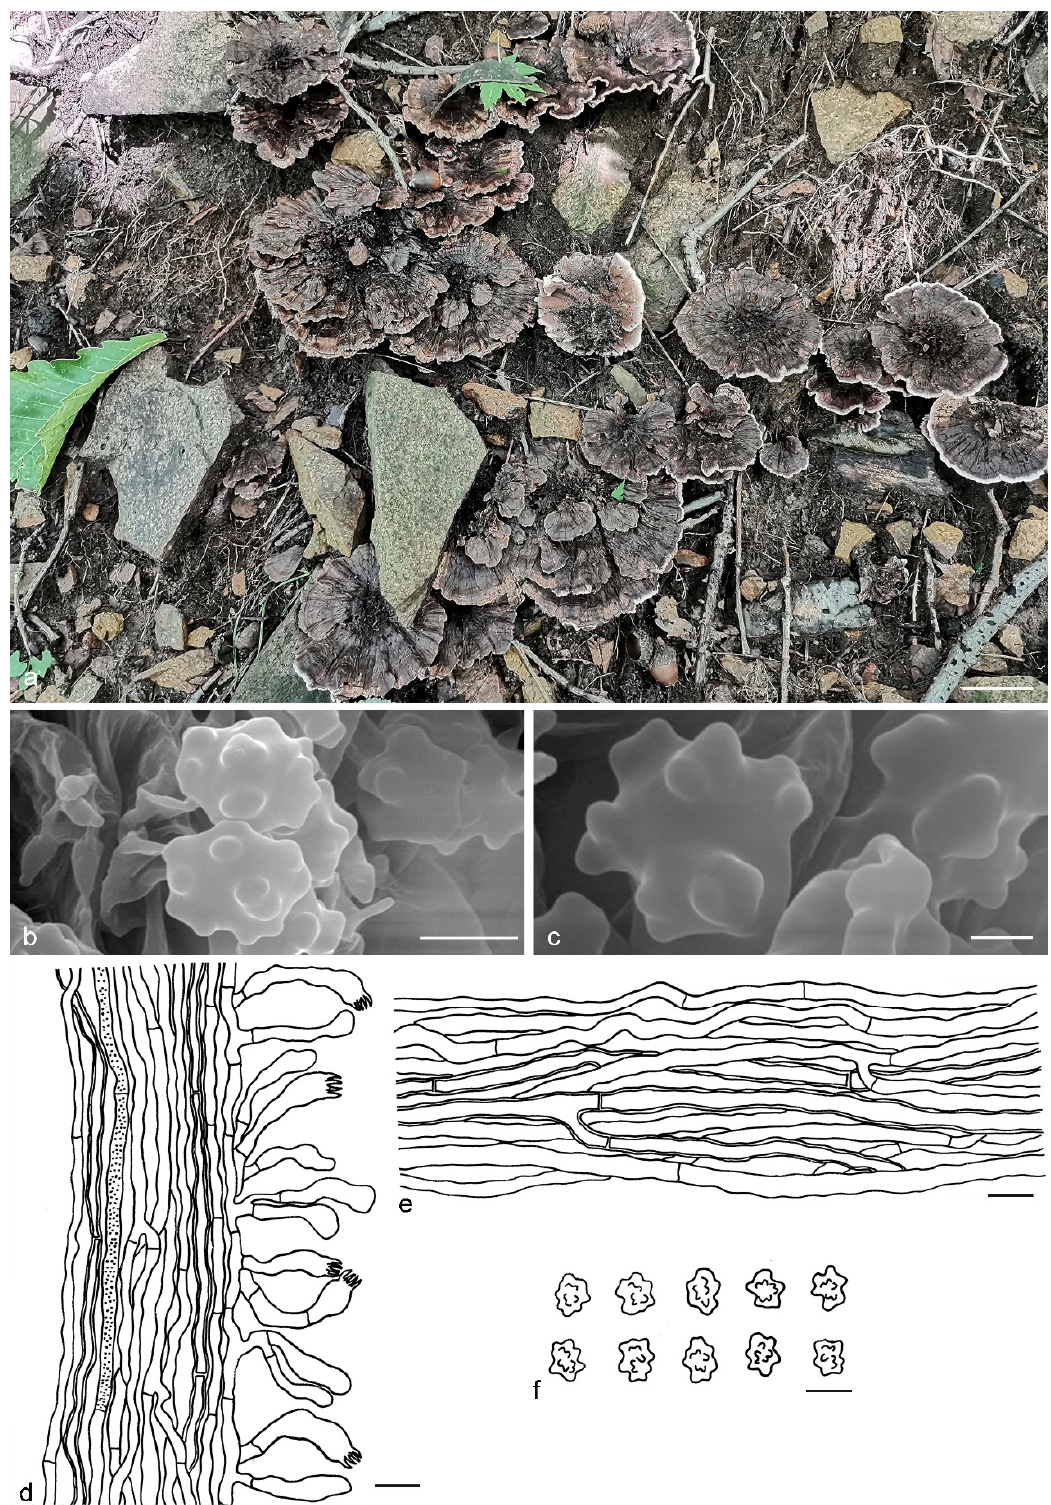
Figure 12. Hydnellum sulcatum. ( a ): Basidiocarps; ( b , c ): SEM of basidiospores; ( d – f ): Microscopic structures (drawn from IFP 019424); ( d ): Section of hymenophore trama with basidia; ( e ): Hyphae from pileus context; ( f ): Basidiospores. —Scale bars: ( a ) = 2 cm; ( b ) = 3 μm; ( c ) = 1 μm; ( d , e ) = 10 μm; ( f ) = 5 μm. Hydnellum yunnanense Y.H. Mu, X.H. Wang & H.S. Yuan, sp. nov. (Figure 13) MycoBank MB839044